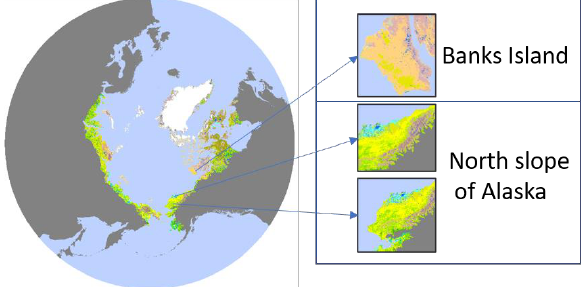
Figure 1. Circumpolar arctic vegetation map (CAVM) (Raynolds et al. 2019) showing the study area.